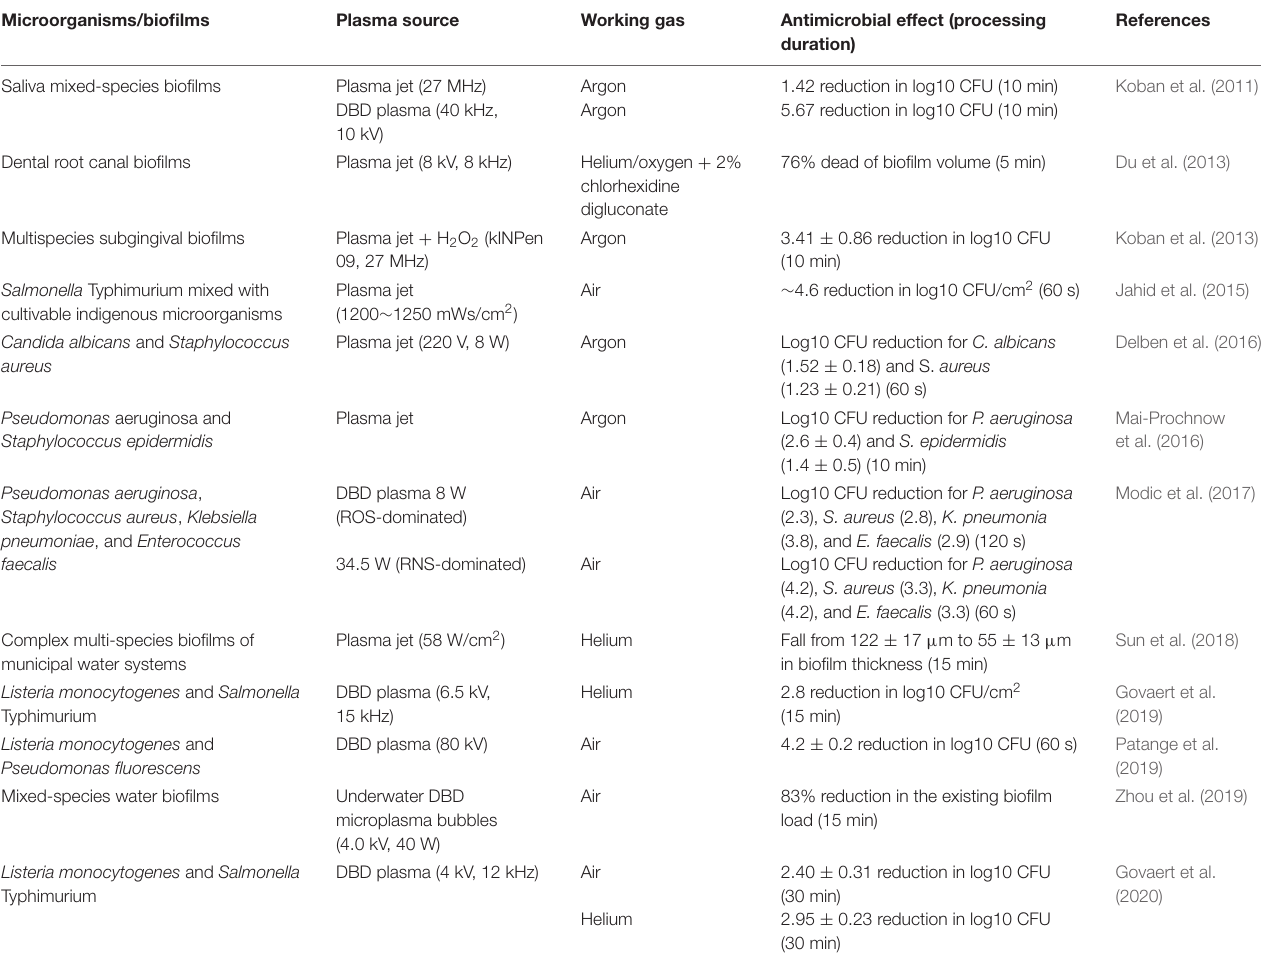
TABLE 2 | Direct CAP activity against mixed-species